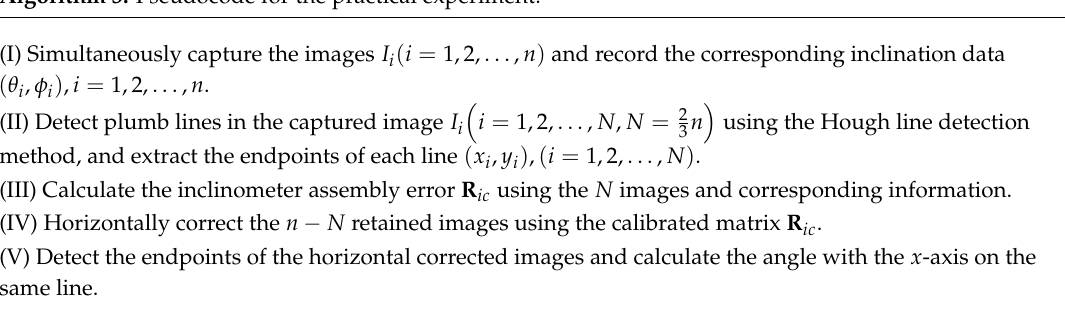
Algorithm 3: Pseudocode for the practical experiment.